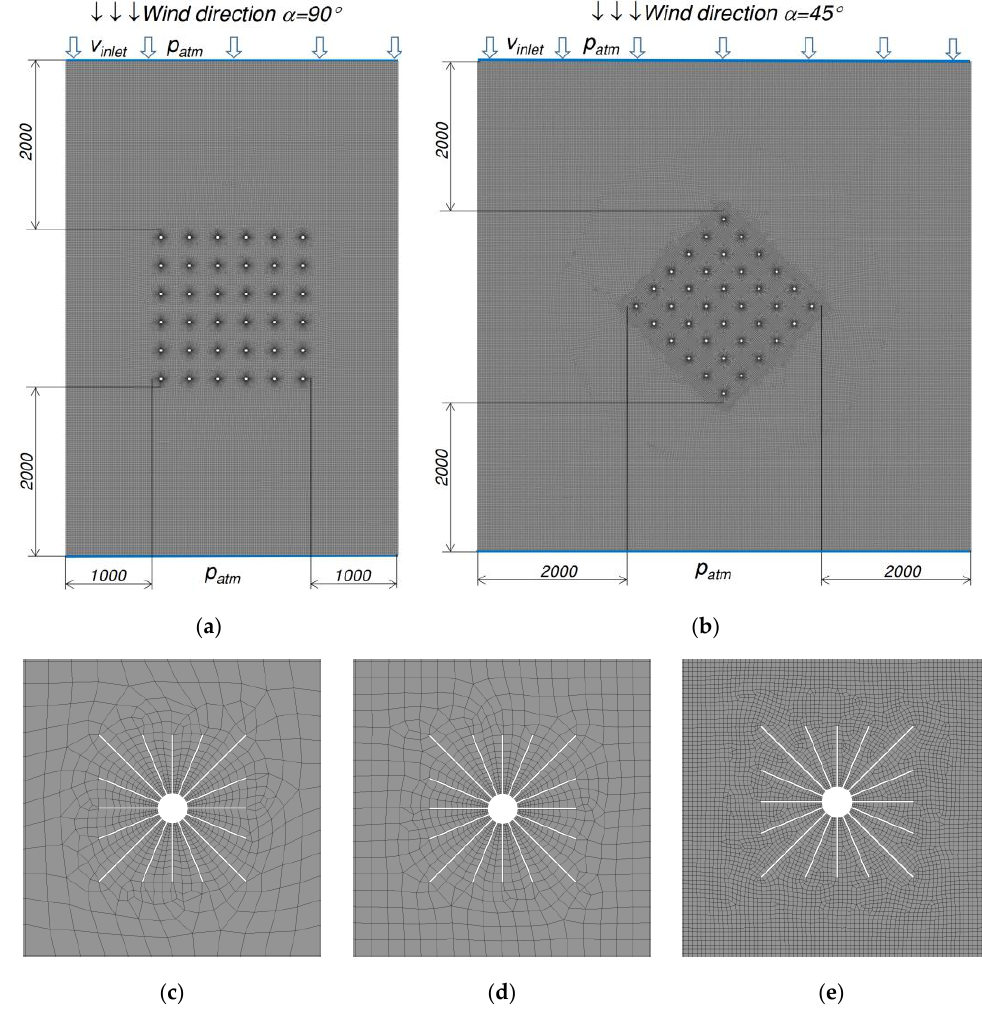
Figure 3. Mesh for wind direction of: ( a ) 90 ◦ , ( b ) 45 ◦ ; Mesh detail around longitudinal finned tube for: ( c ) ref.1, ( d ) ref.3, ( e ) ref.4.